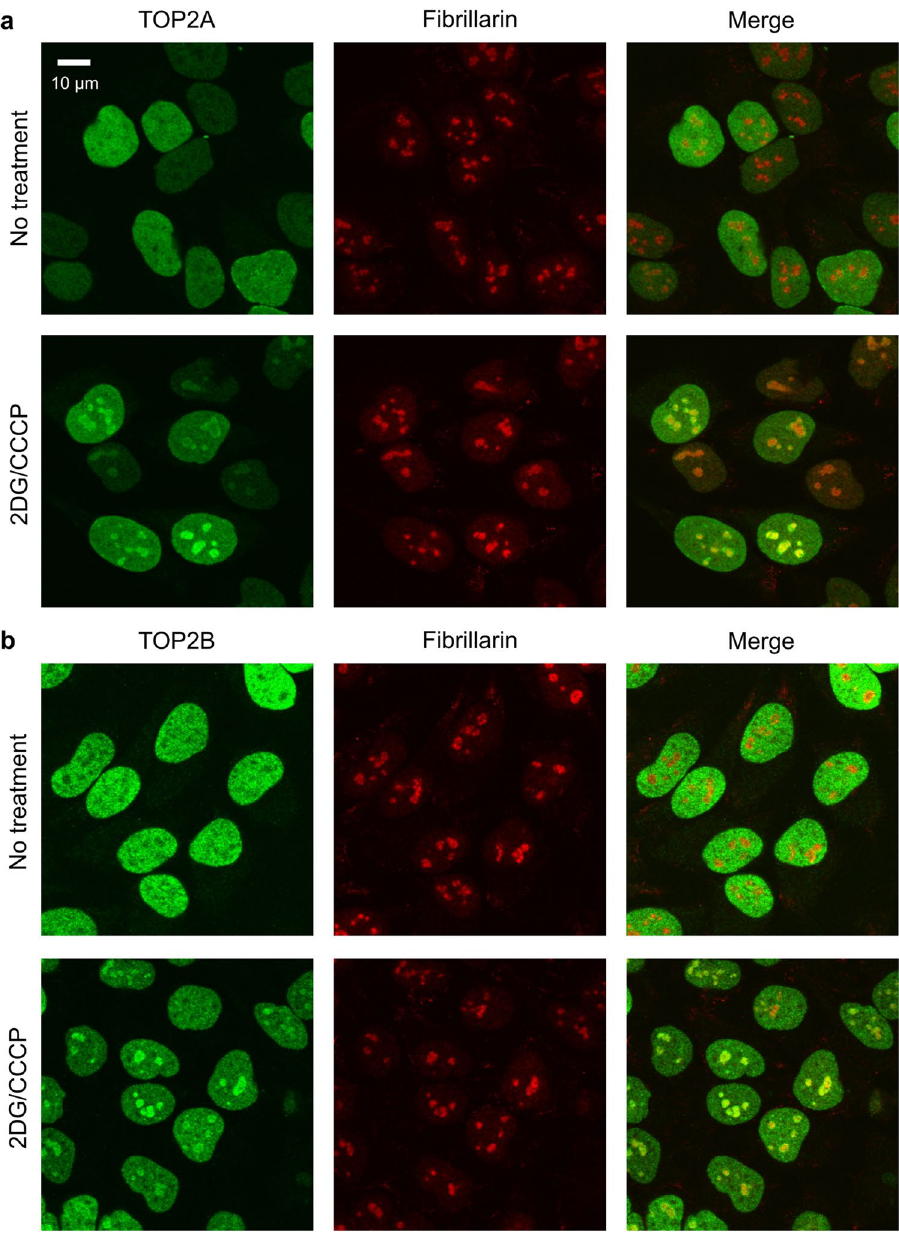
Figure 2. Endogenous TOP2A and TOP2B proteins are localized to the nucleoli in ATP-depleted cells. ( a ) Immunofluorescence staining for endogenous TOP2A and fibrillarin. HeLa cells were incubated with or without 25 mM 2DG/10 µM CCCP for 30 min. Cells were subjected to coimmunostaining for endogenous TOP2A (green) and fibrillarin (red). ( b ) Coimmunostaining for endogenous TOP2B (green) and fibrillarin (red) was performed as described in ( a